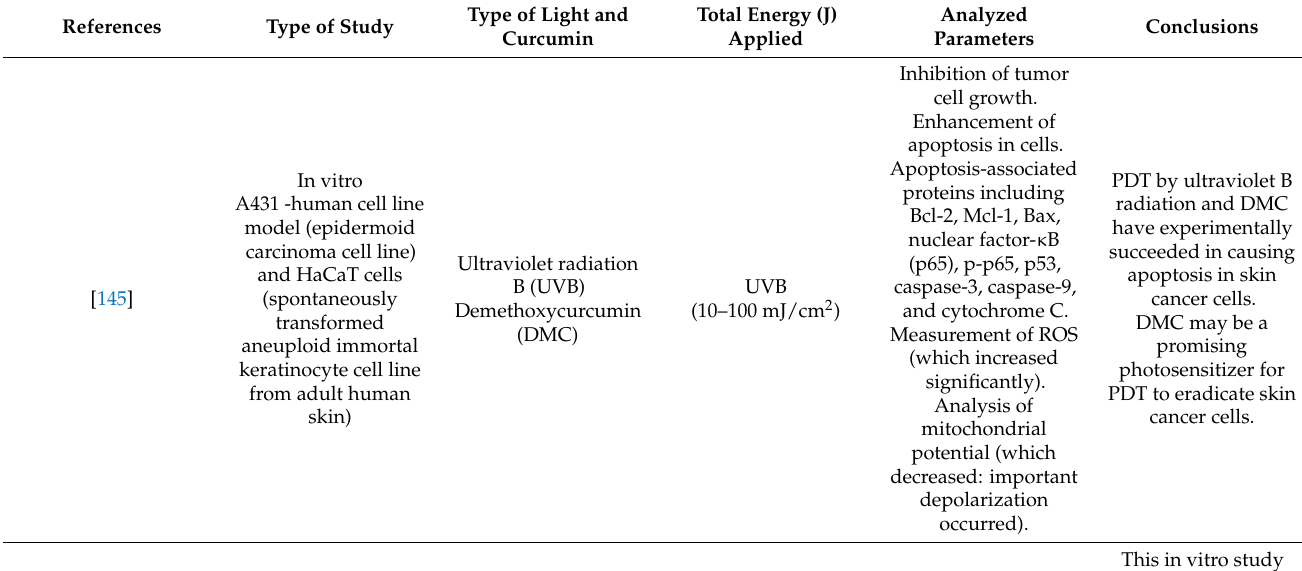
Table 2. Nanocurcumin in skin cancer